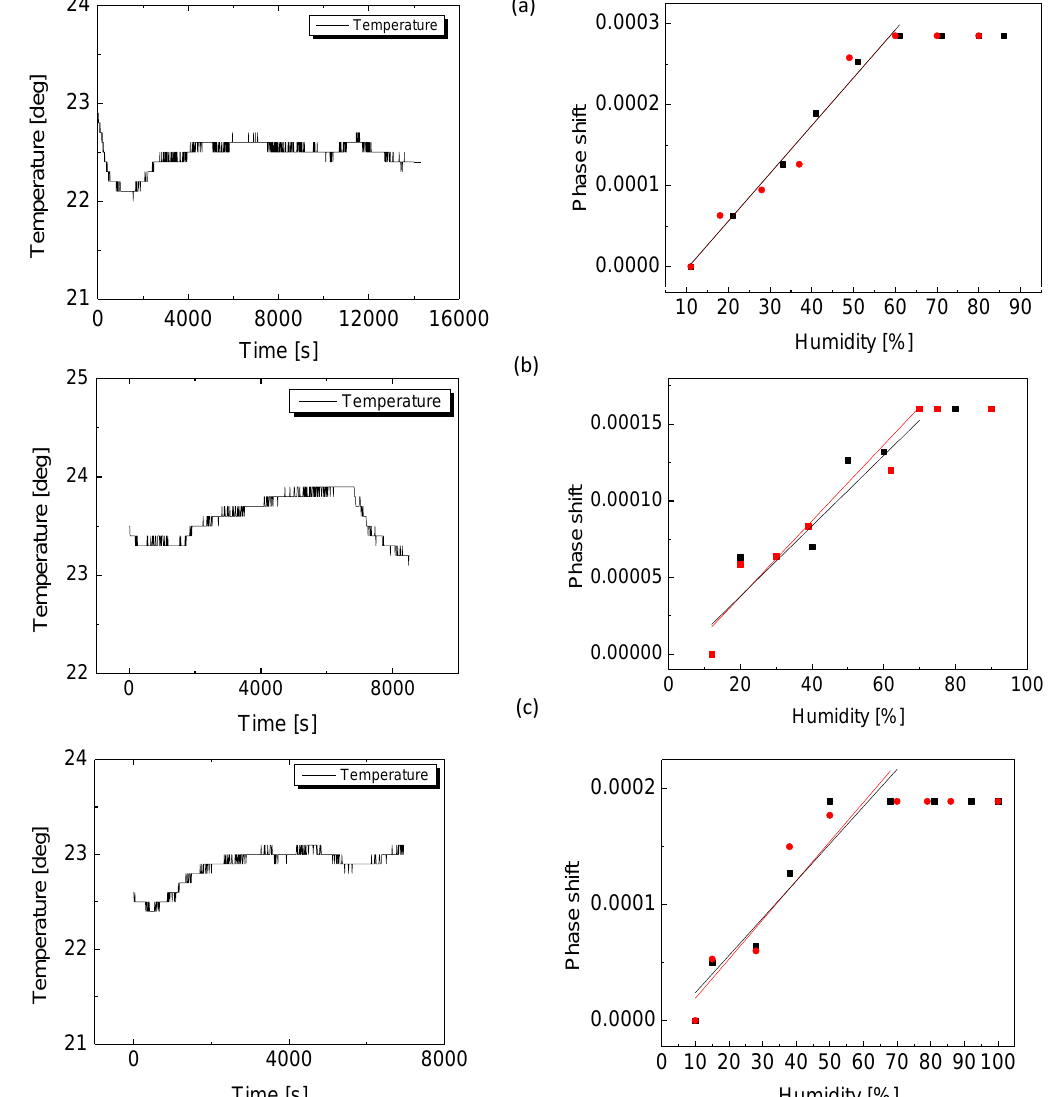
Figure 5. Thick 450 nm coated straight taper results: temperature stability (left) and relative phase shifts as a function of relative humidity (RH) levels, in exposure to: ( a ) DI water, ( b ) Ethanol, ( c )